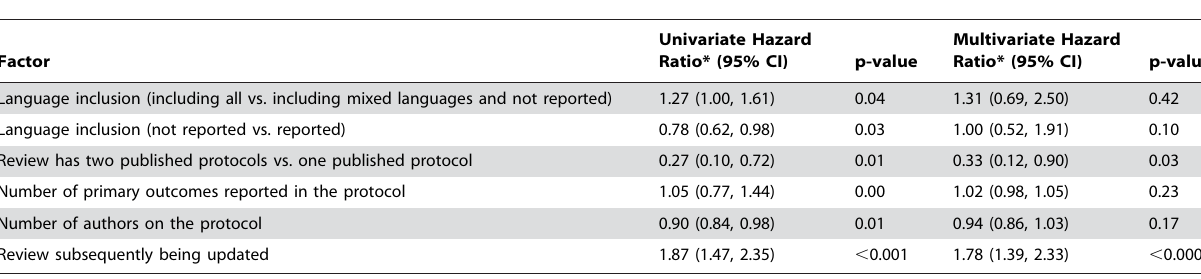
Table 2. Factors predicting the time to publication of Cochrane reviews